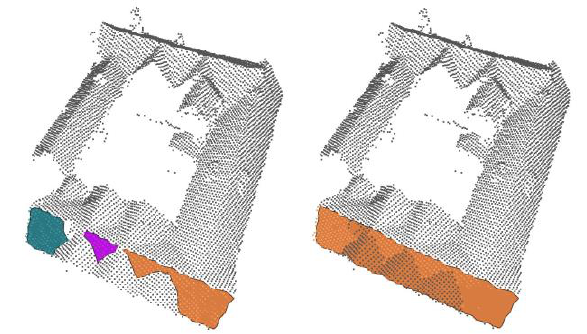
Figure 1. Segmentation of planar region as a result of surface growing (left) and sub-surface growing (right).